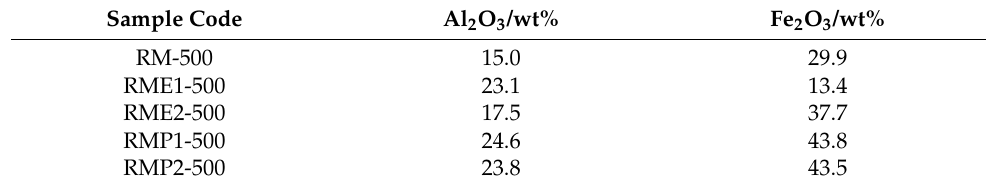
Table 1. Bulk composition of red mud and leaching red mud samples from ICP-OES